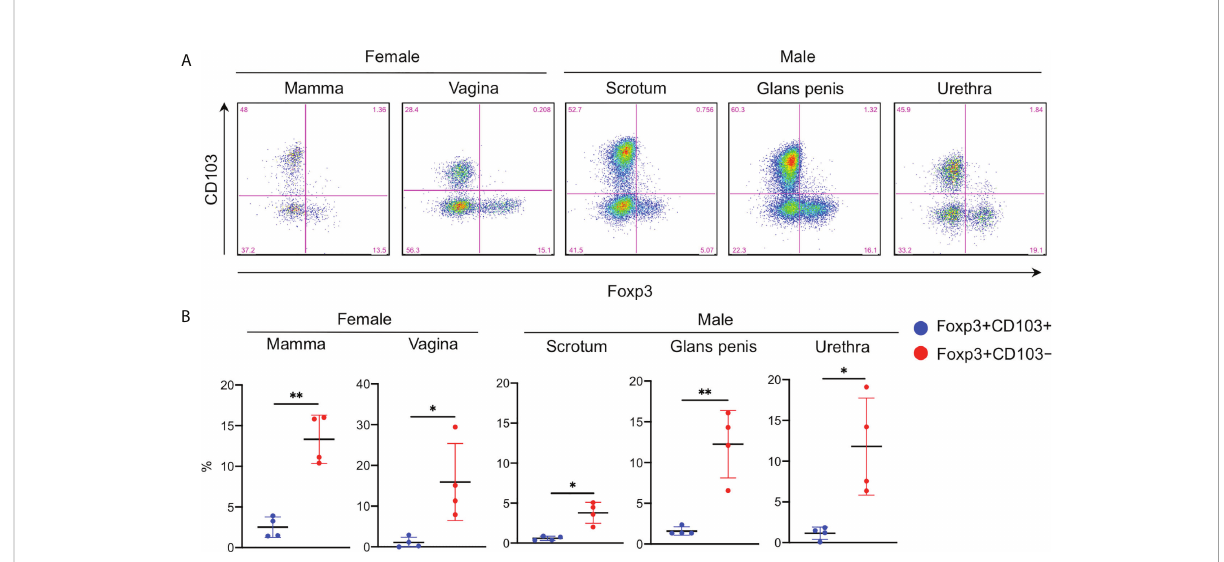
FIGURE 3 Predominant Foxp3 expression in the various epidermal and epithelial CD4 + CD103 − cells. (A) Representative Foxp3 and CD103 expression in the epithelial CD3 + CD4 + cells from the various organs. (B) A summary of the indicated population percentage in the epidermal CD3 + CD4 + cells. One set of samples of mamma and vagina were not from same volunteers. This means these samples were from six different volunteers. Conversely, one set of samples of scrotum, gland penis, and urethra were from one volunteer. This means these samples were from three different volunteers. Comparisons between groups were evaluated using Student ’ s t -test (one-tailed); * p < 0.05 and ** p <